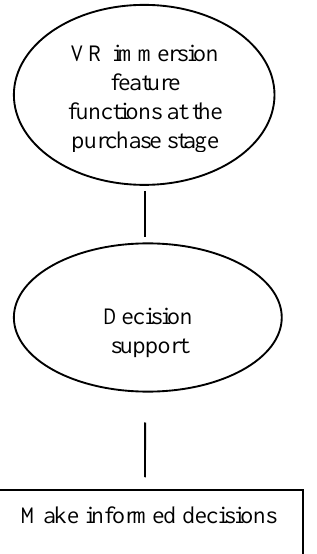
Figure 6 - VR immersion feature functions in the pre-purchase stage